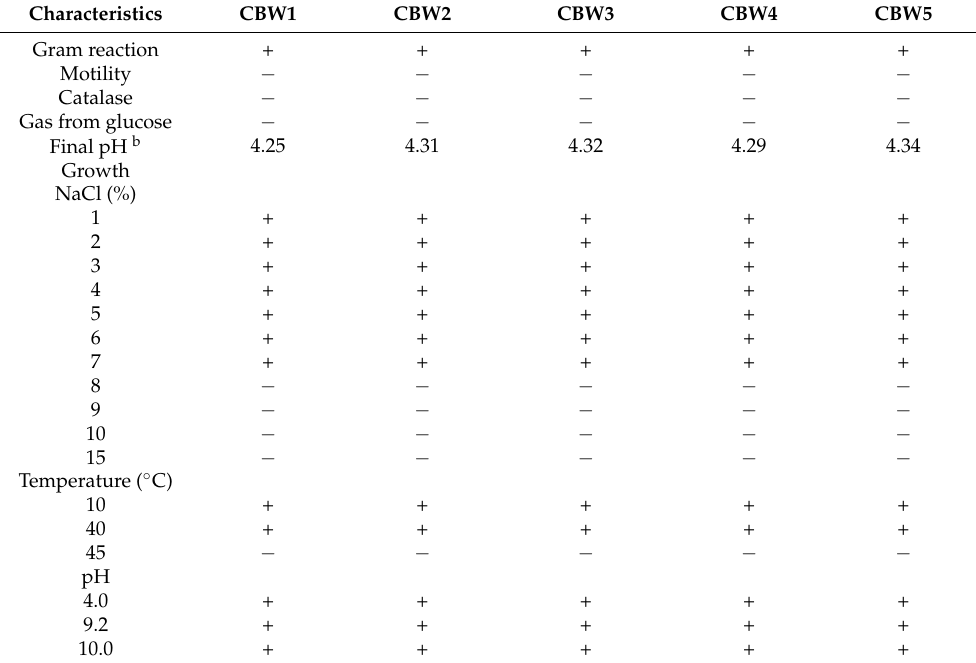
Table 5. Phenotypic characteristics of the five Lactococcus lactis subsp. lactis strains isolated from the fecal sample of a stranded female Cuvier’s beaked whale a